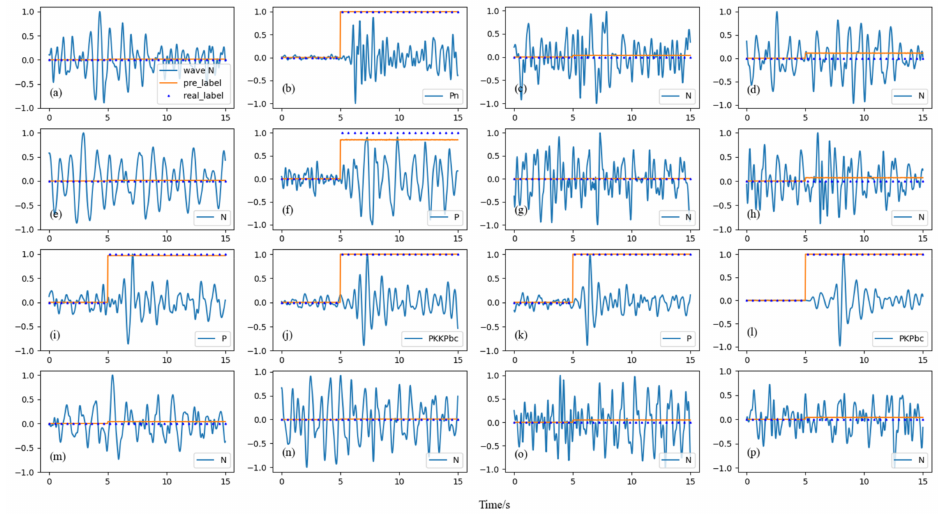
Figure 14. The identification results of MKAR seismic phases. (In the a – p subfigure, the blue “ . . . ” denotes a real signal category,1 means seismic phase, 0 means noise signal; the yellow “—” denotes a model-predicted signal category. The predicted results of these samples are consistent with actual